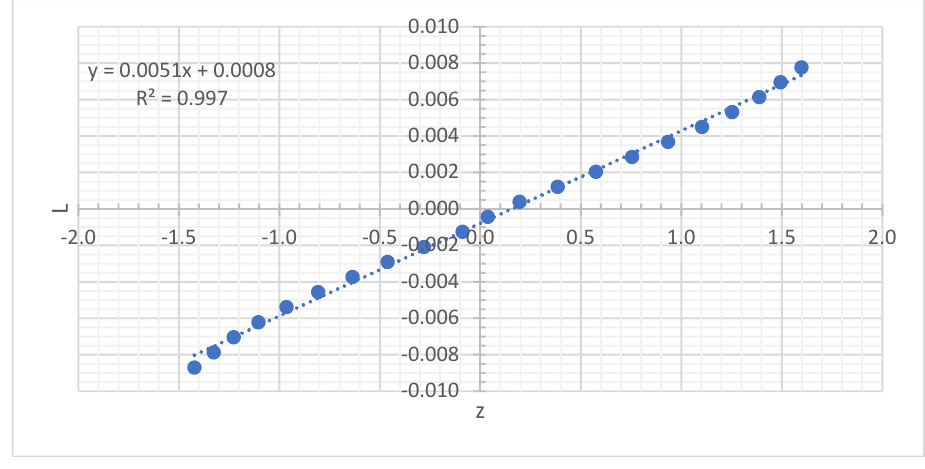
Figure 3. Fitting a GBM model to the PITM-s for the Nadex Gold data of 8 February 2022.